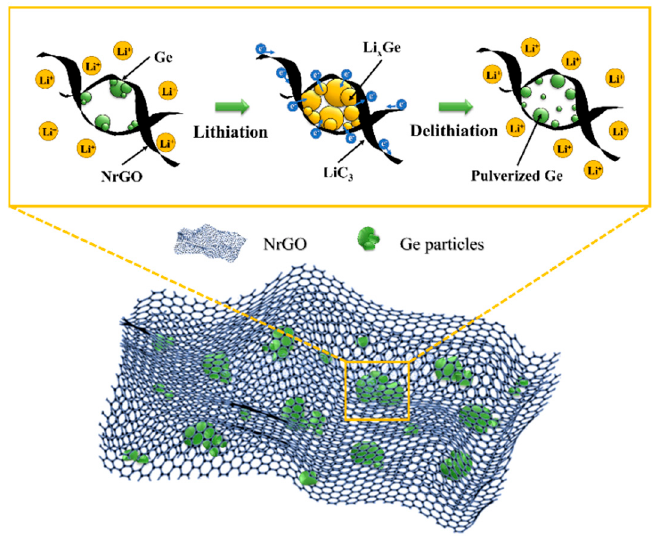
Figure 10. Schematic illustration of Ge/NrGO transformation between an expanded state and a contracted state during lithiation and delithiation processes.